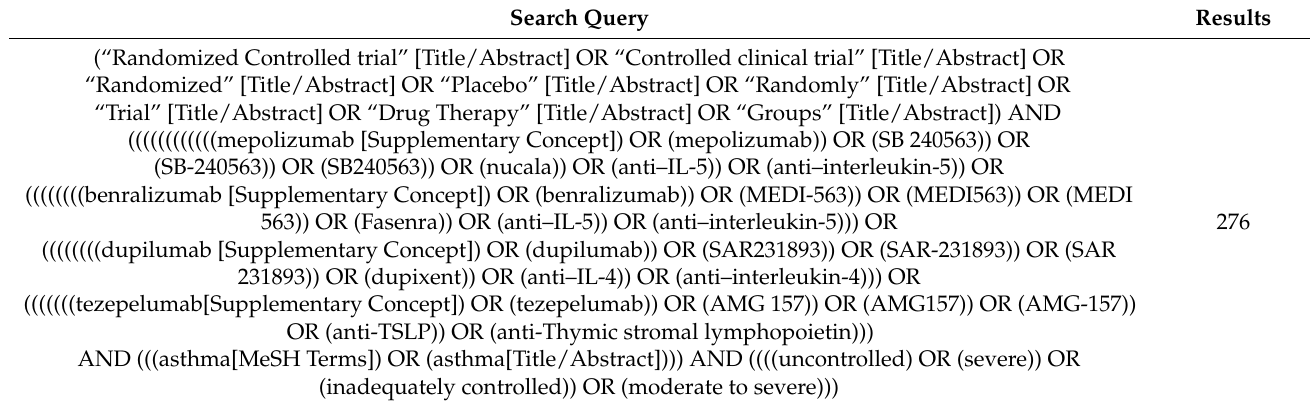
Table A1. Search Strategies in PubMed (searched on 26 July